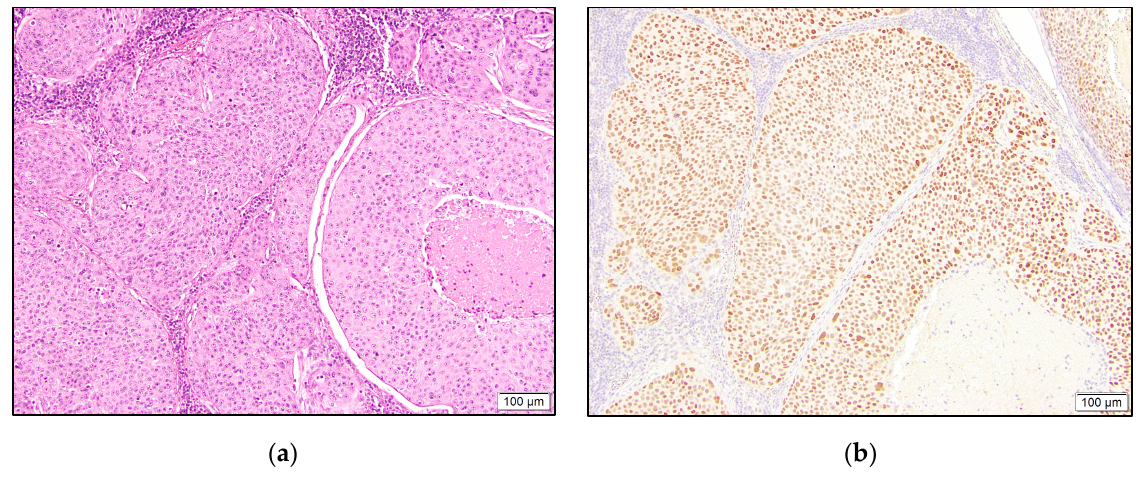
Figure 3. Porocarcinoma with back-to-back tumor nodules comprising occasional ducts and eosinophilic tumor cells ( a ) that stained positive for TRPS1 ( b ). In the benign category, eight hidradenoma cases were intermediate to high positive, one was low positive, and two were negative. Similar to the eccrine adenocarcinoma case, four hidradenomas showed stronger staining in the cells lining cystic or ductular spaces (Figure 4).